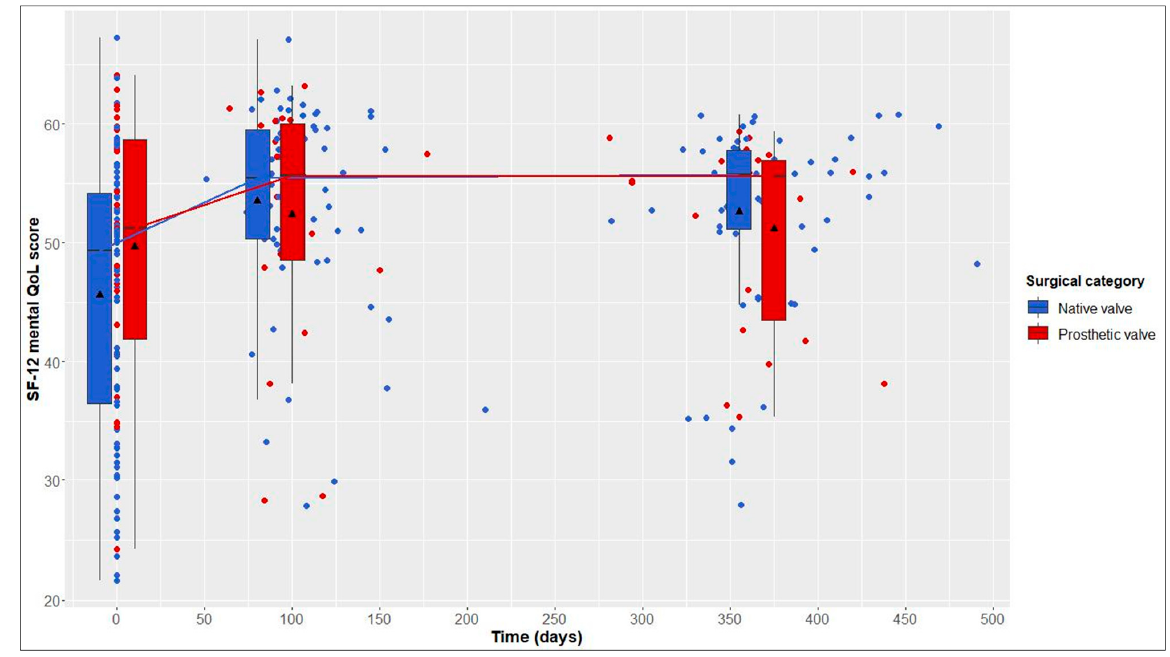
Figure 3. 12-Item Short Form Health Survey (SF-12) mental quality of life (QoL) score over time in native valve vs. prosthetic valve patients; boxes and whiskers indicate medians, IQRs, minima and maxima (raw data); triangles indicate means (raw data); medians are connected to show time trend.